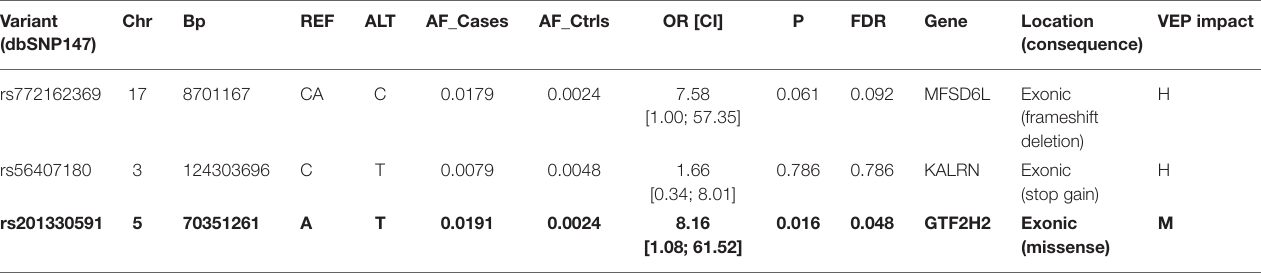
TABLE 1 | Association statistics (OR and 95% Confidence Interval) of the most frequent genetic variants detected through the variant prioritization pipeline in our PD callset. Variant